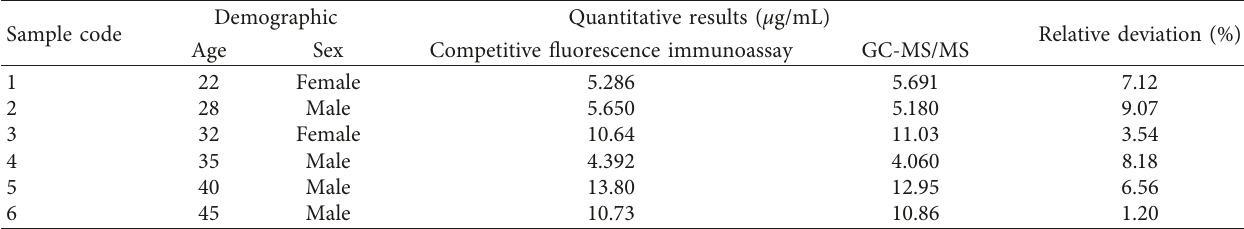
Table 4: MOR concentrations in urine of medicolegal